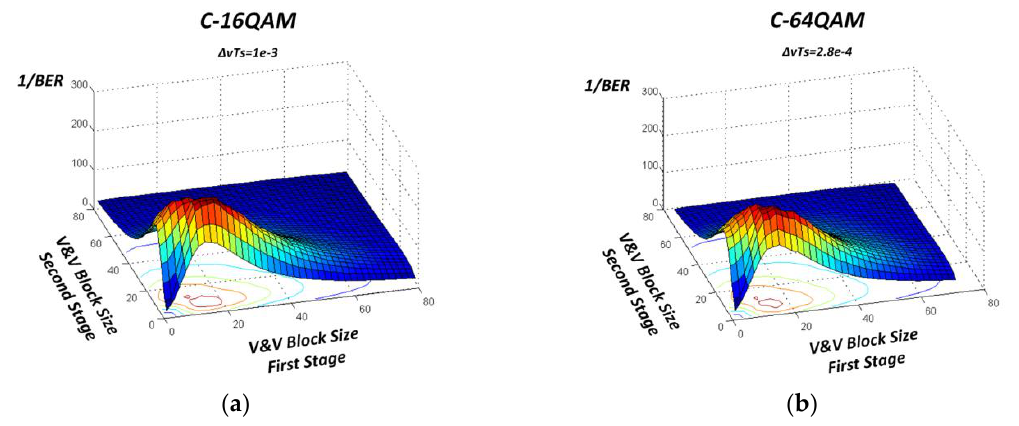
Figure 5. Influence of the block size of each of the stages on the performance of the proposed two-stage n-PSK partitioning CPR scheme in ( a ) a C-16QAM constellation and ( b ) a C-64QAM constellation.